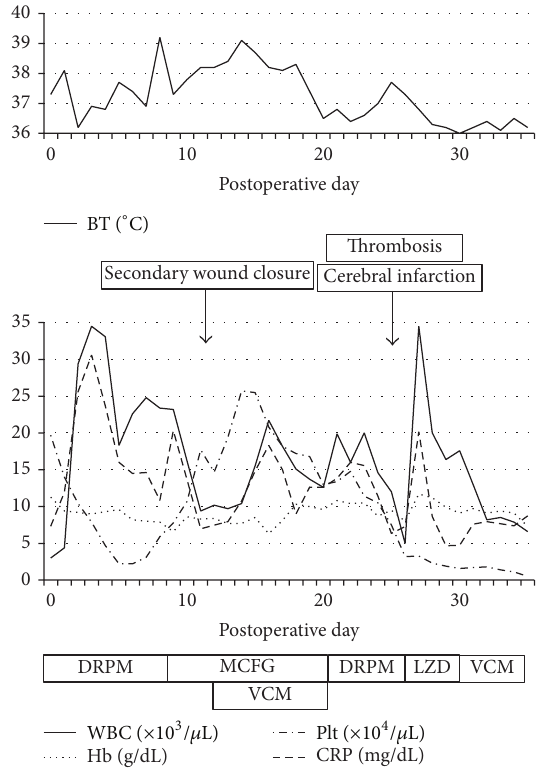
Figure 3: Postoperative course. BT: body temperature; WBC: white blood cell count; Hb: hemoglobin; Plt: platelet; CRP: C- reactive protein; DRPM: doripenem; MCFG: micafungin; VCM: vancomycin; LZD: